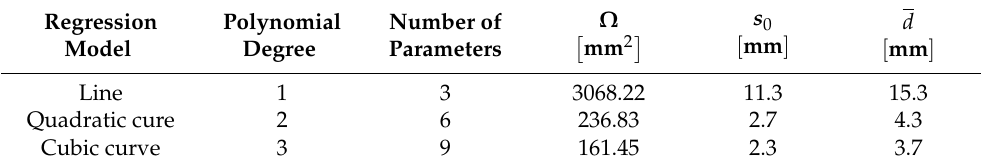
Table 8. Description and evaluation parameters of the polynomial regression models of the chimney axis based on the reference TS data set.